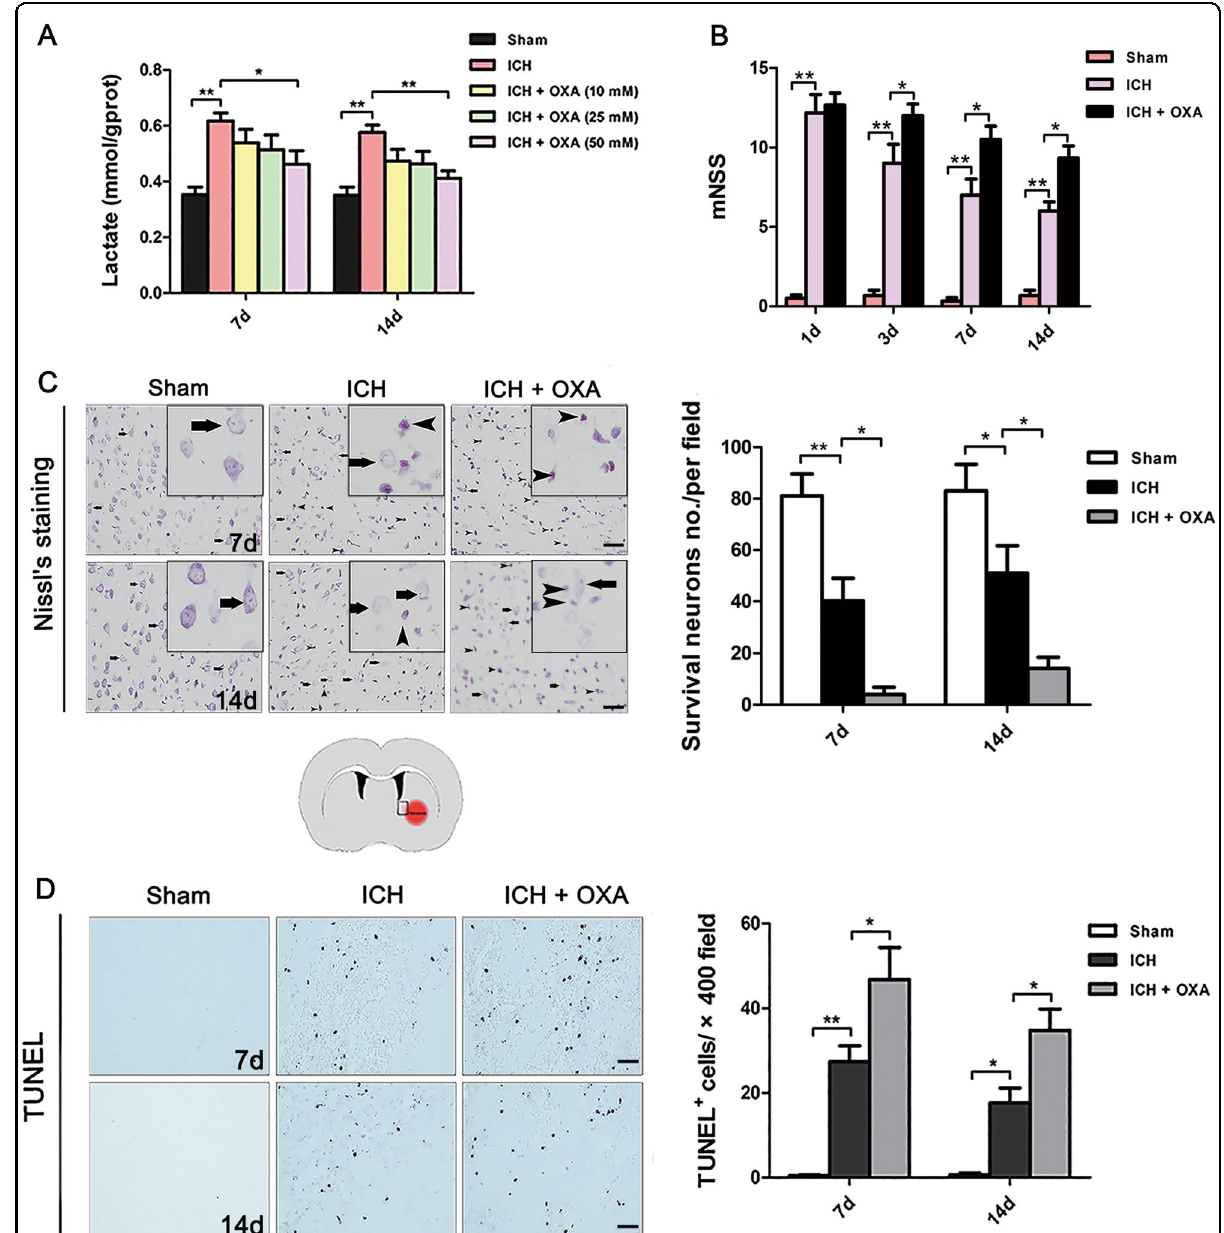
treated rats showed a signi fi cantly increased mNSS compared with that of the ICH group ( n = 8). c Nissl staining showed that many neurons in the ICH group were damaged (arrows without tails); the number of surviving neurons (arrows with tails) was markedly reduced. In the OXA group, far fewer surviving cells were observed ( n = 5). d TUNEL-positive cells markedly increased in abundance after ICH. In particular, the number of TUNEL- positive cells was signi fi cantly increased in the OXA-treated group after ICH ( n = 5). ICH intracerebral hemorrhage, OXA oxamate. * p < 0.05